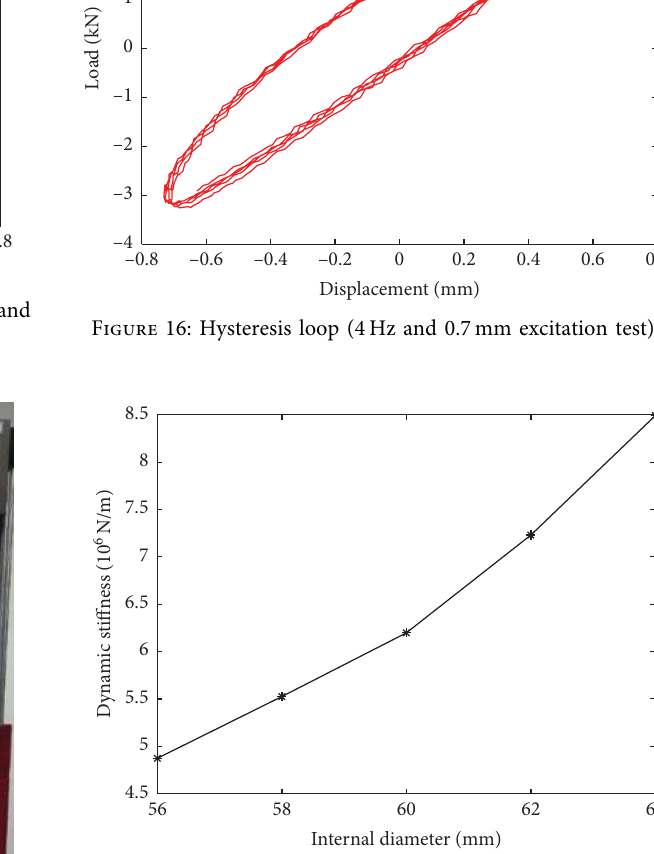
Figure 17: Influence of inner damping ring diameter on dynamic stiffness.